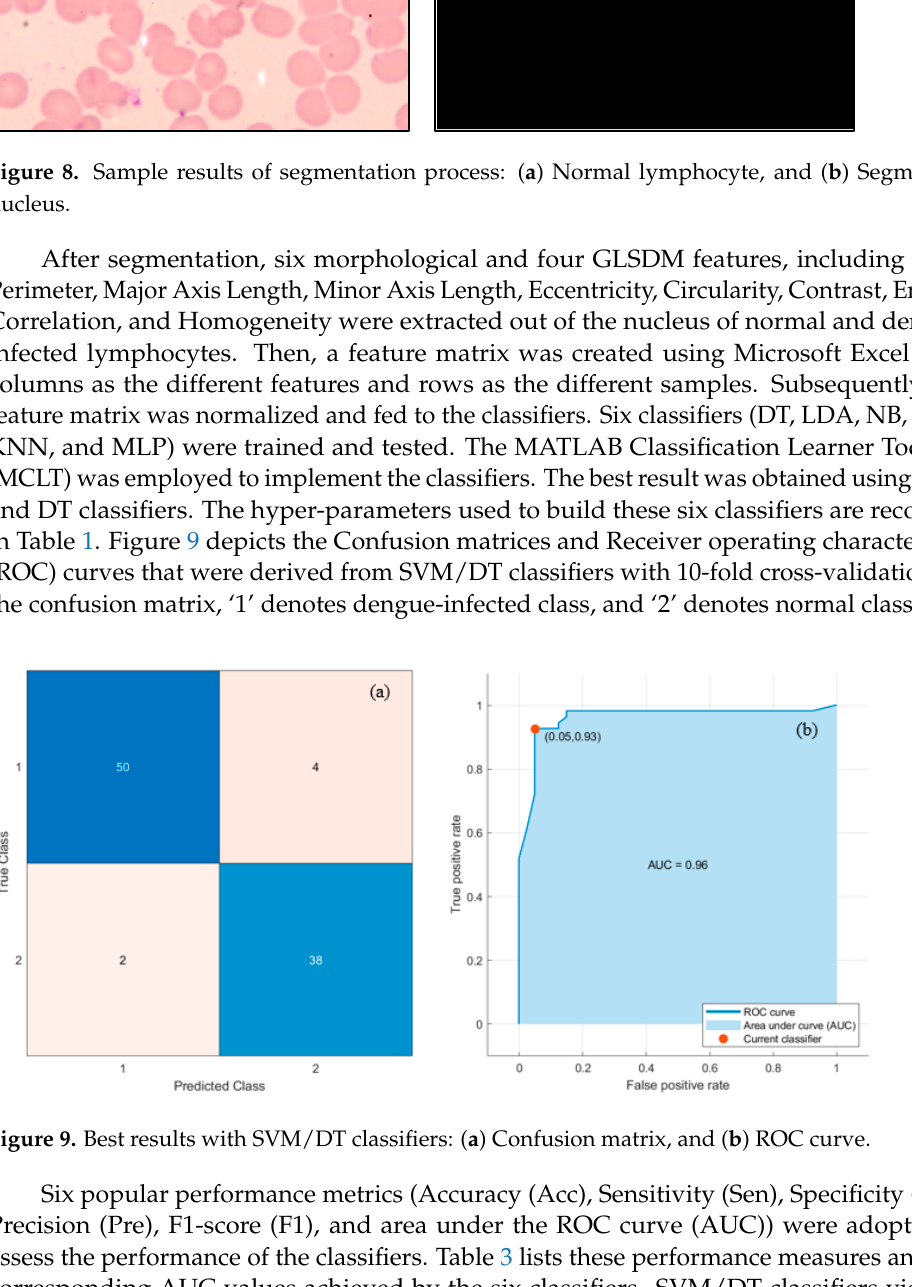
Table 3. Performance measures achieved by the classifiers trained and tested with morphologi- cal/GLSDM features.